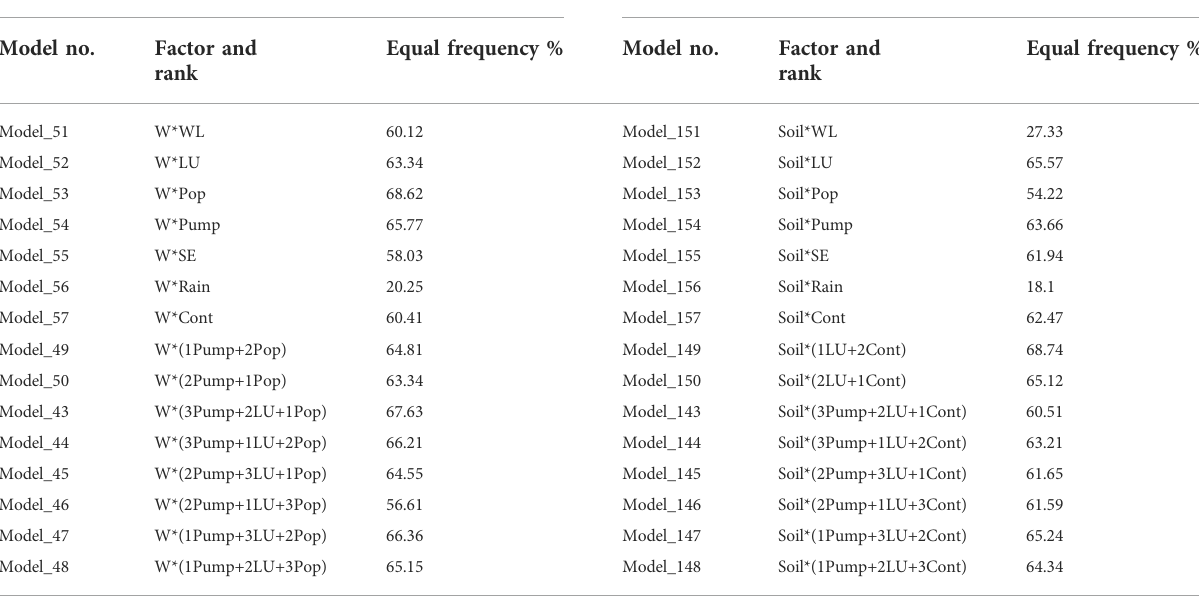
TABLE 1 Model frequencies of factor correlations with arsenic concentrations in the water and soil. Surface water and groundwater (W) Soil Model